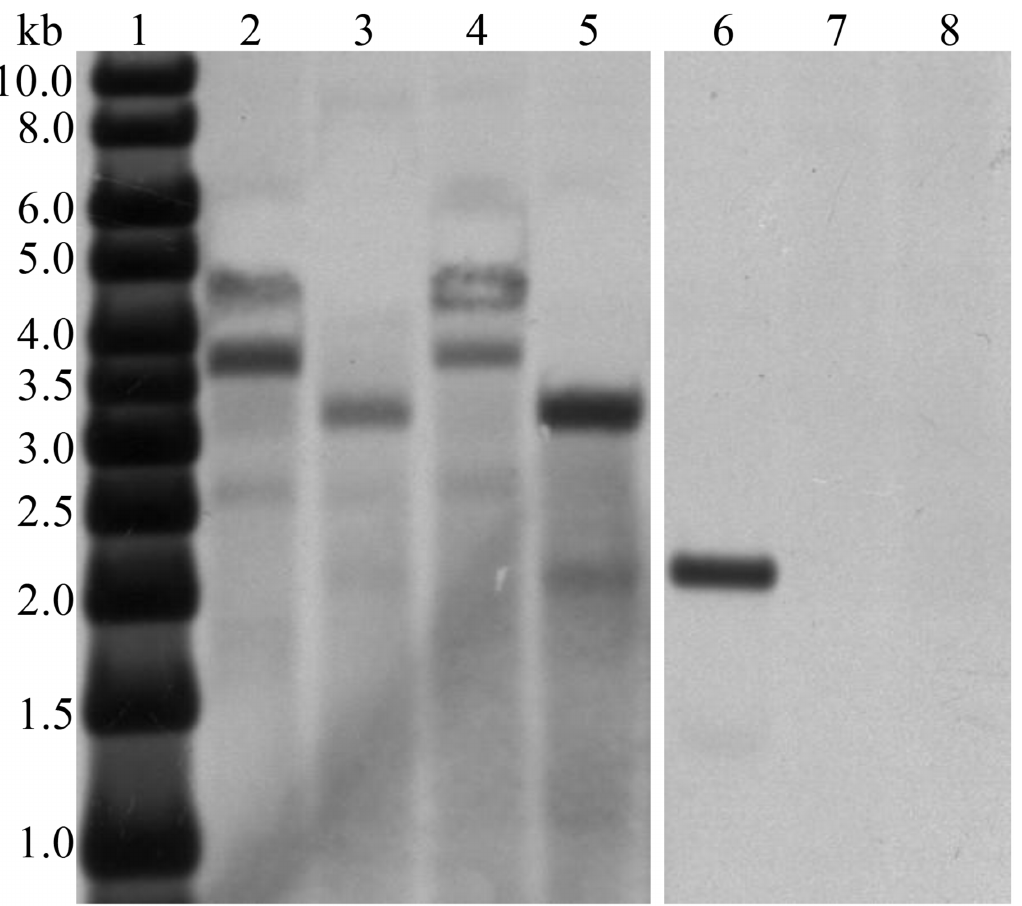
Fig 3. Southern blot analysis of aga-F75m in two transgenic plants. Lanes: 1, the DIG-labeled molecular weight markers; 2 and 4, the aga-F75m fragment with Bam HI digest; 3 and 5, the aga-F75m fragment with Hind III digest; 6, the digested expression cassettes as a positive control; 7 and 8, the genome of non-transgenic Zheng58 digested by Bam HI and Hind III, respectively.